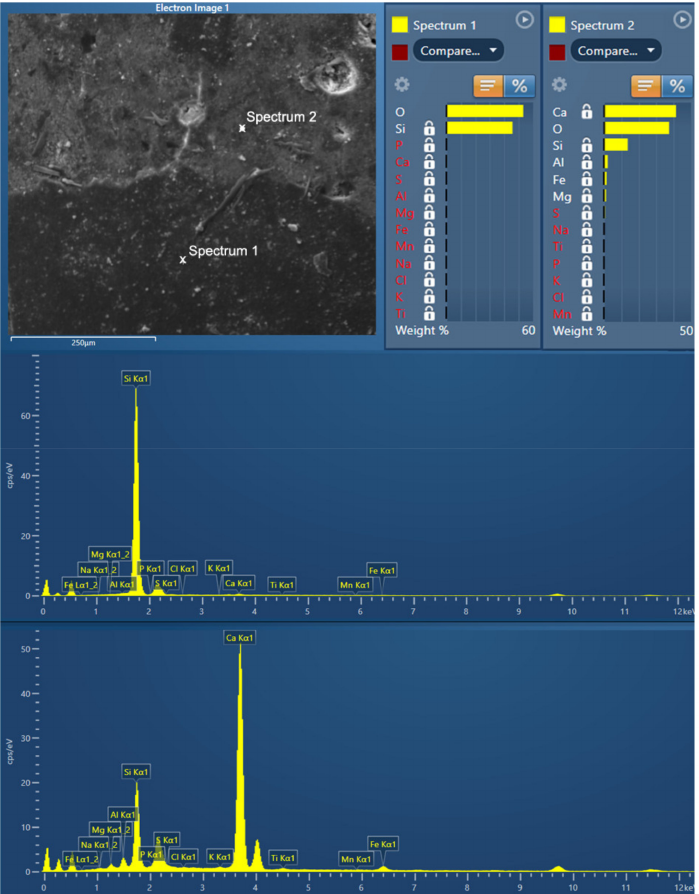
Figure 5. EDS analysis for the identification of conventional aggregates in the mortar